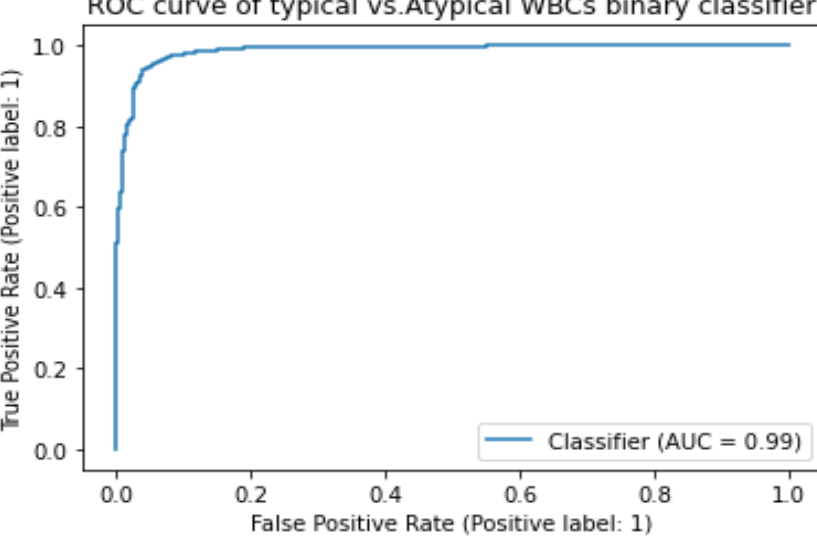
Figure 9. Stage I DCAE-CNN classification model ROC